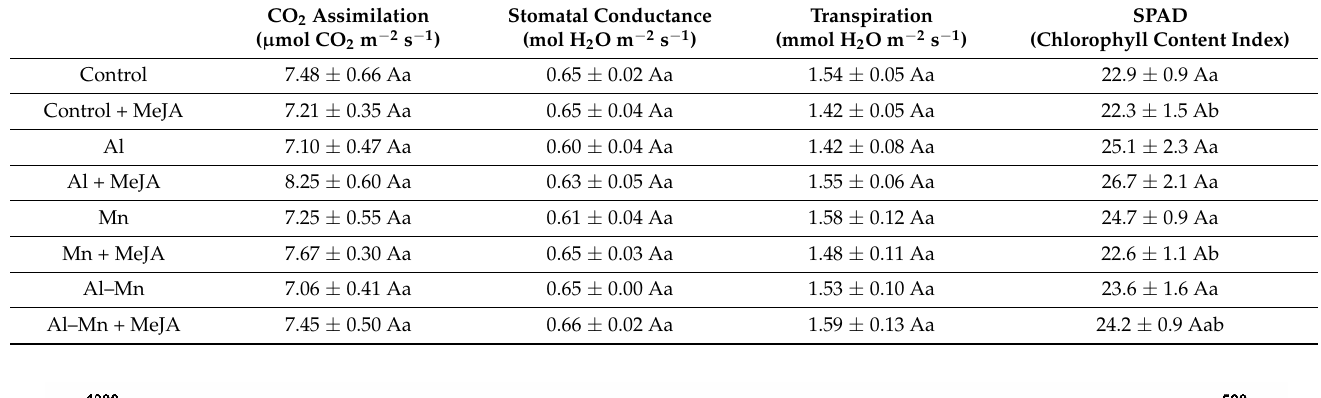
Table 1. Photosynthetic performance in highbush blueberry cv. Legacy plants subjected to different soil treatments (Al, Mn, and Al–Mn toxicity), and exogenous MeJA. All values represent averages of ten biological replicates ± SE. Different upper-case letters indicate significant differences between MeJA treatments for the same soil conditions, according to Tukey’s test ( p ≤ 0.01). Different lower-case letters indicate significant differences among soil conditions for the same MeJA treatment according to Tukey’s test ( p ≤ 0.01).